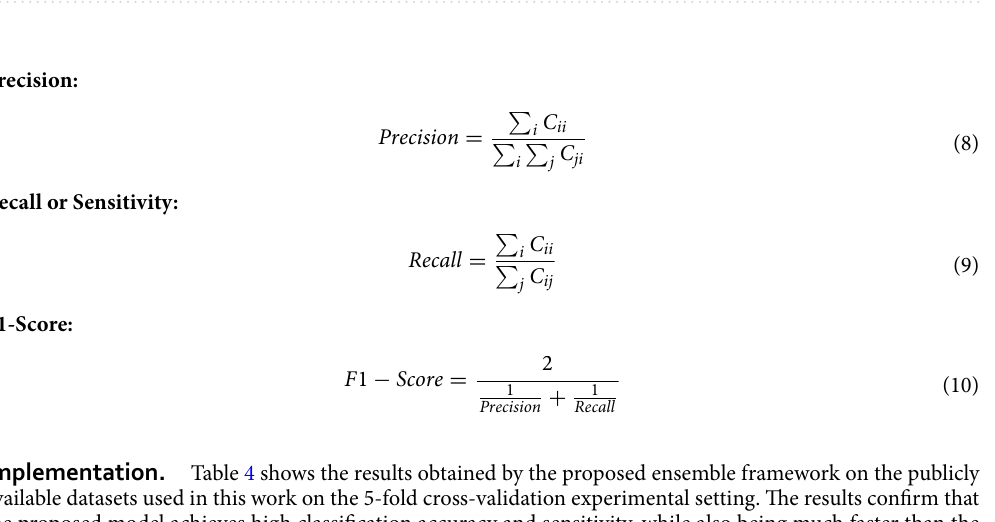
Table 4. Results obtained by the proposed framework on the three publicly available datasets used in this study, considering fivefold cross-validation scheme. Avg average of the fivefolds, Std. Dev. standard